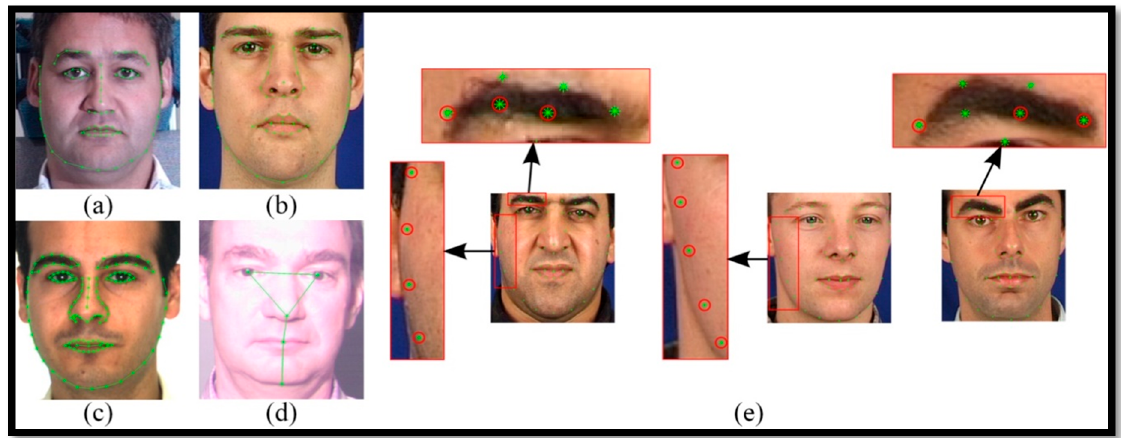
Figure 4. An example of sample frames that are taken from the University of Texas at Arlington Real-Life drowsiness